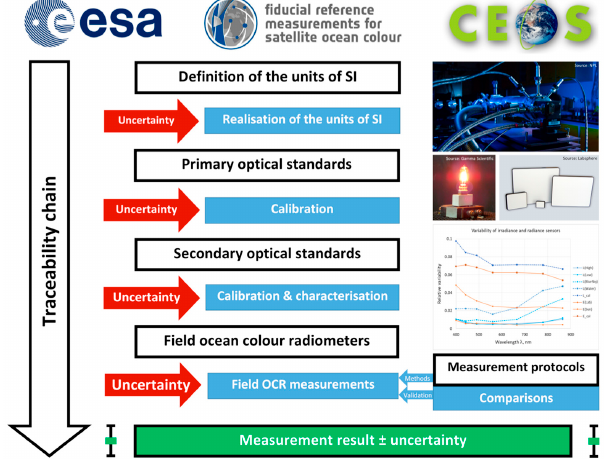
Figure 1. FRM4SOC project overview: a focus on SI traceability and the addition of uncertainty at each step of the FRM process.